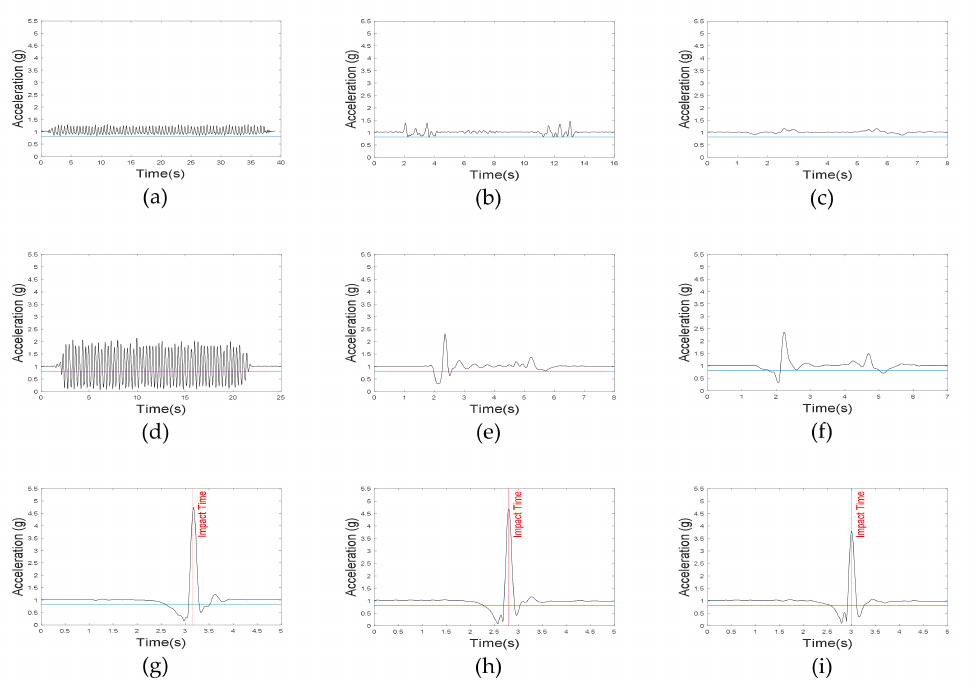
Figure 8. Acceleration SVM graphs. Less-dynamic motions: ( a ) walking, ( b ) climbing up and down the stairs, and ( c ) slowly sitting on the stool and getting up. Highly dynamic motions: ( d ) jogging, ( e ) quickly sitting on the chair and getting up, and ( f ) quickly sitting on low-height mattress and getting up. Fall motions: ( g ) backward fall, ( h ) lateral fall, and ( i ) twist